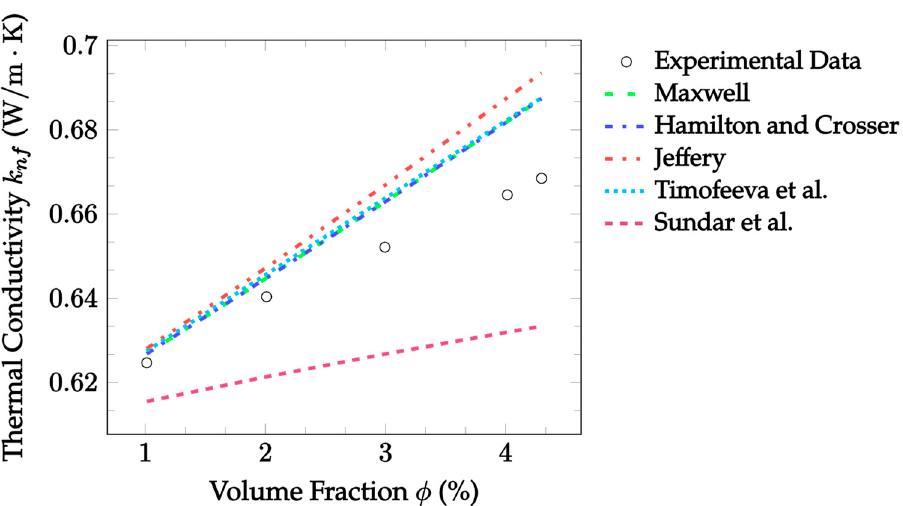
Figure 1. EMT model predictions compared with experimental data for spherical Al 2 O 3 –water nanofluid at 300 K with volume fractions between 1.0–4.3%: Experimental Data [12], Maxwell [14], Hamilton and Crosser [15], Jeffery [16], Timofeeva et al. [17], Sundar et al. [18].